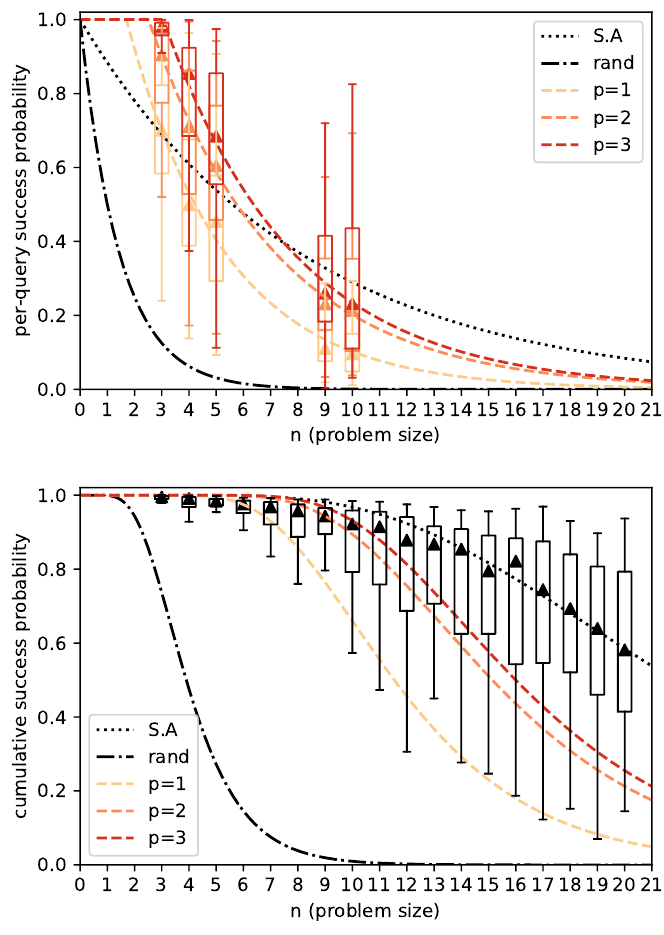
Figure 4: Comparison of success probabilities of sampling the ground state, for QAOA at depths p = 1,2,3, simulated annealing and random sampling. (TOP) shows the success probability per-query and (BOTTOM) shows the cumulative success proba- bility after 10 queries. The box plots indicate the nature of the experimental results (with medians as triangles) while curves in the figure are fitted to them. The QAOA results are from the statevector (no noise) experiments as described in Section 3.3.1 and the approach for comparing it with simulated annealing and random sampling is described in Section